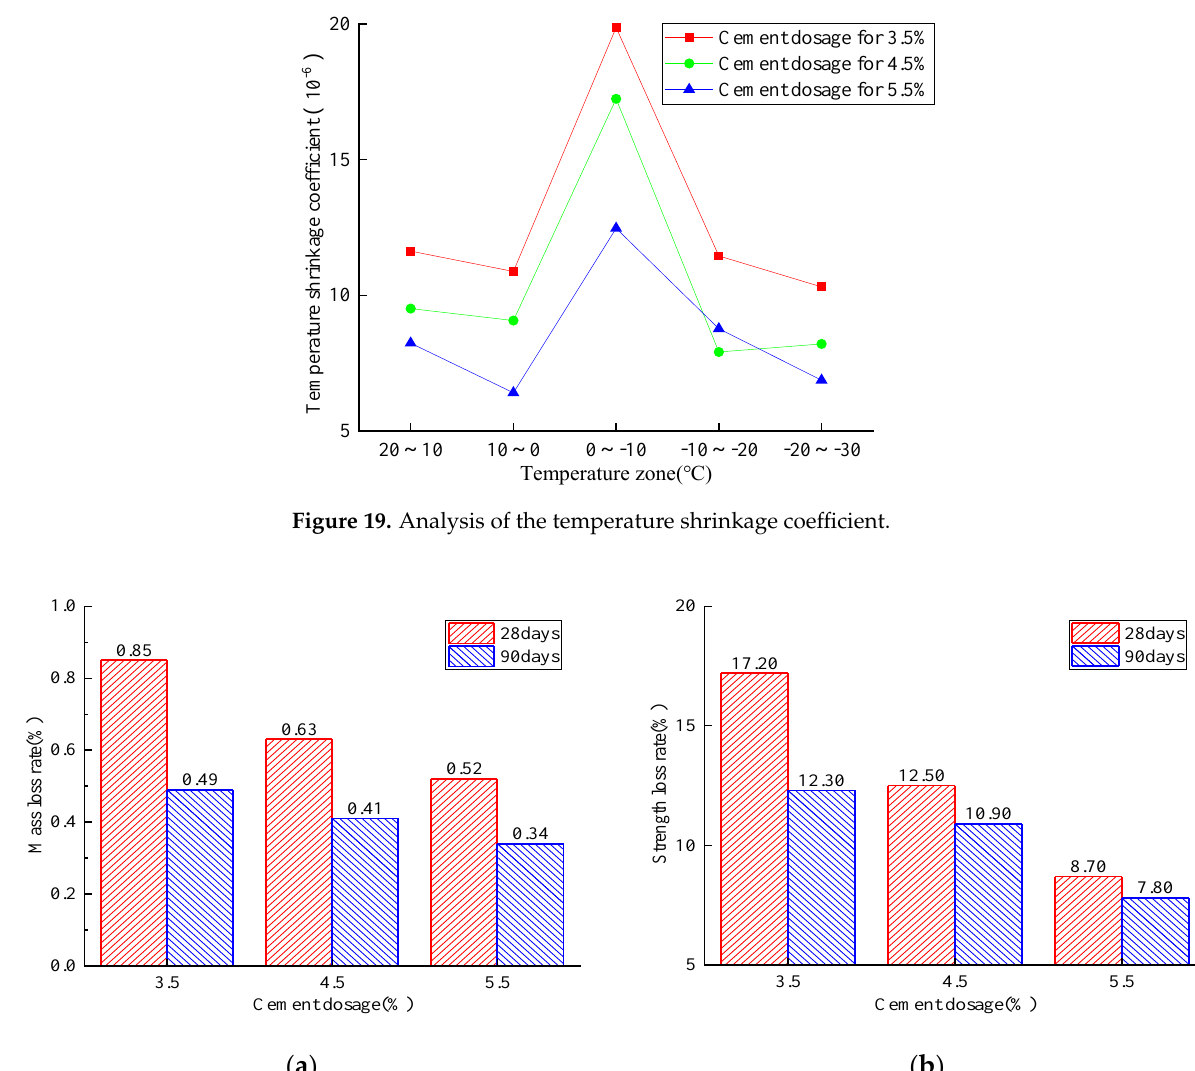
For specimens with 40% reclaimed asphalt and various cement dosages from 3.5% to 5.5%, the compressive strength related to dry–wet cycles (with and without) is